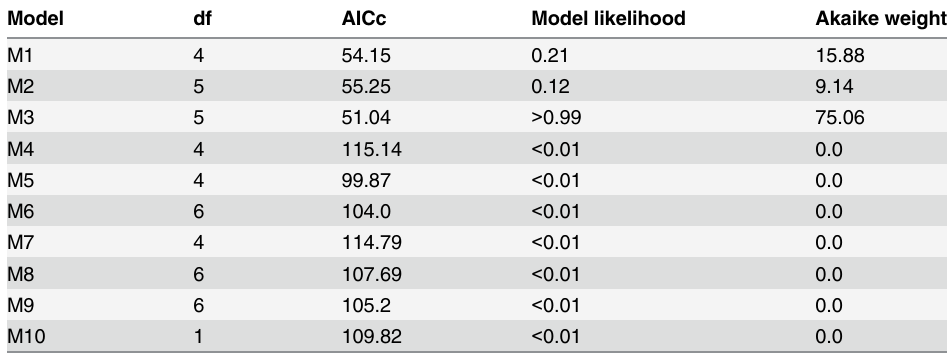
Table 2. Model selection values of the candidate models of binary logistic regression.